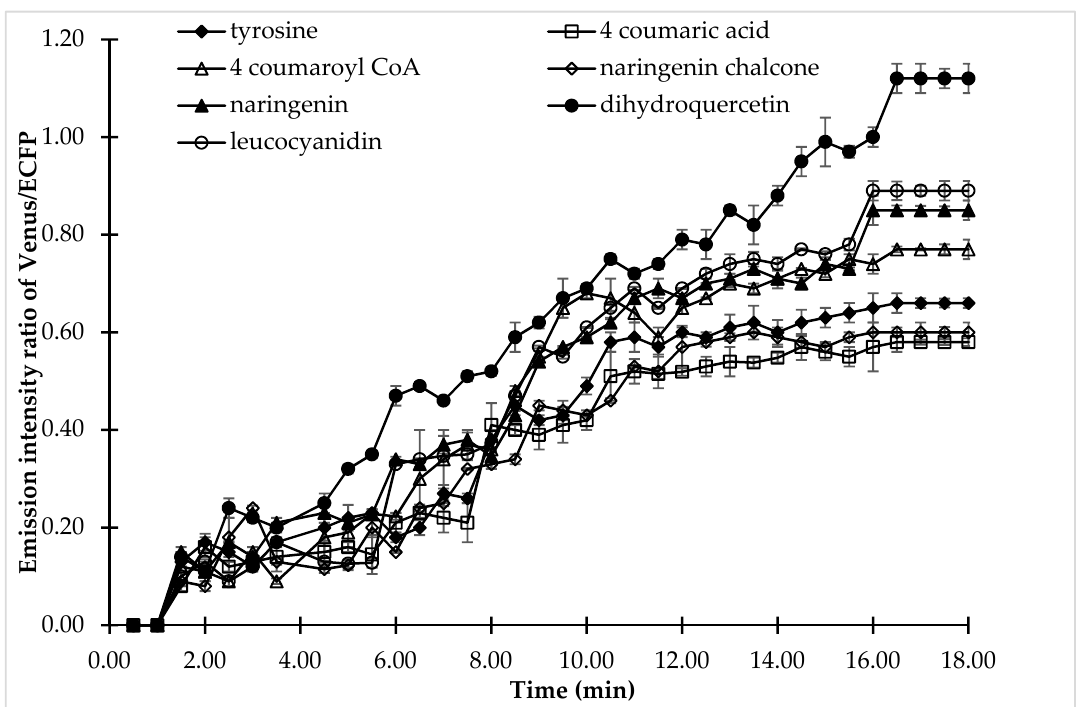
Figure 7. Live cell dynamics of ( + )-catechin production in the same bacterial cell upon addition of the individual substrates of the ( + )-catechin biosynthesis pathway. The graph represents the results of confocal analysis of the same cell, which was examined for ( + )-catechin production by adding the substrates of ( + )-catechin biosynthesis. ( + )-Catechin production is measured on the basis of the emission intensity ratio of Venus / ECFP. Values plotted are means of three independent replicates. Vertical bar indicates standard error.